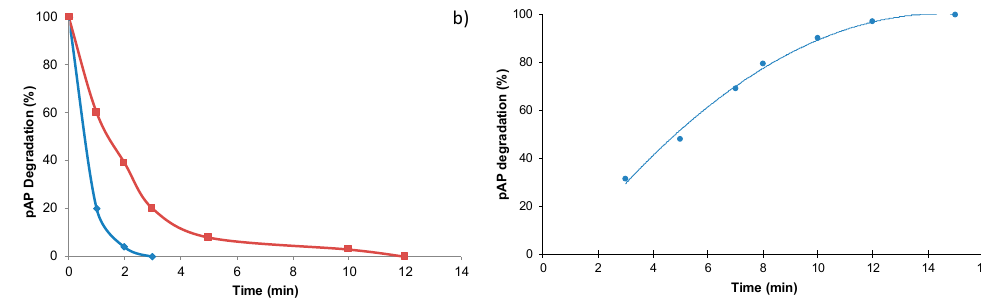
Figure 7. Profile of pAP degradation in water containing 1% ( v/v ) of H 2 O 2 catalyzed by bionanohybrids. ( a ) Comparison between FeCO 3 NRs@CALB (red line) and FeCO 3 NPs@CALB ‐ Mentha (blue line) at 2 mL reaction volume. ( b ) FeCO 3 NPs@CALB ‐ Mentha at 10 mL reaction volume. The amount of catalyst was 3 mg in all cases.